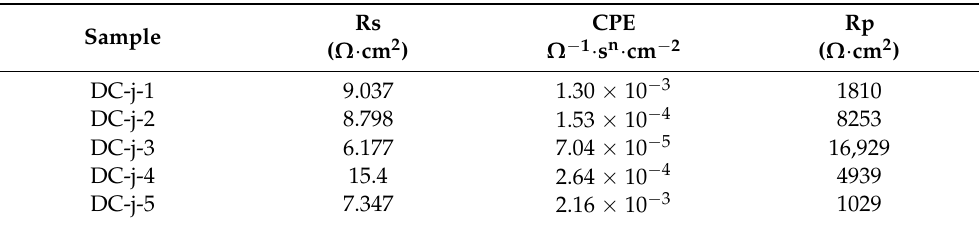
Figure 6. The equivalent electrical circuit for fitting the EIS of the coatings. Table 4. Equivalent electrical circuit parameters obtained by fitting the Nyquist plots of the coatings prepared under different current